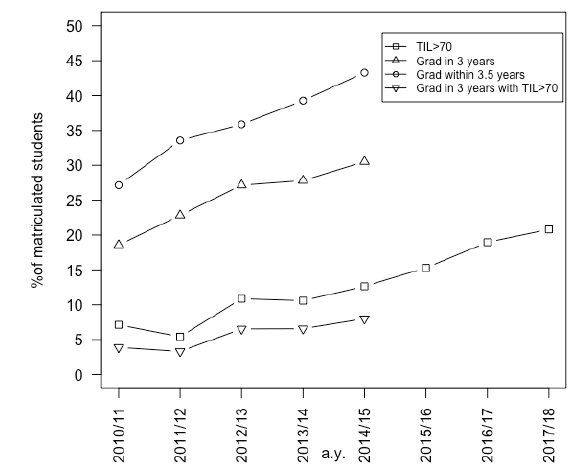
Fig. 4. Percentage distribution of overall matriculated students based on enrolled ones and of students with TIL score higher than 70/100